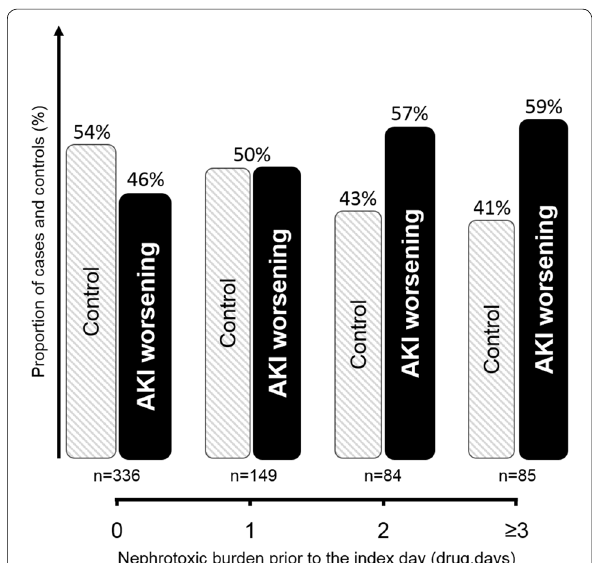
Fig. 2 Proportion of cases and control patients among the 327 matched pairs according to increasing nephrotoxic burden prior to the index day (see text for definition). The proportion of cases of acute kidney injury (AKI) occurrence/worsening increased and the proportion of controls decreased with increasing nephrotoxic burden, thus supporting a dose–response relationship